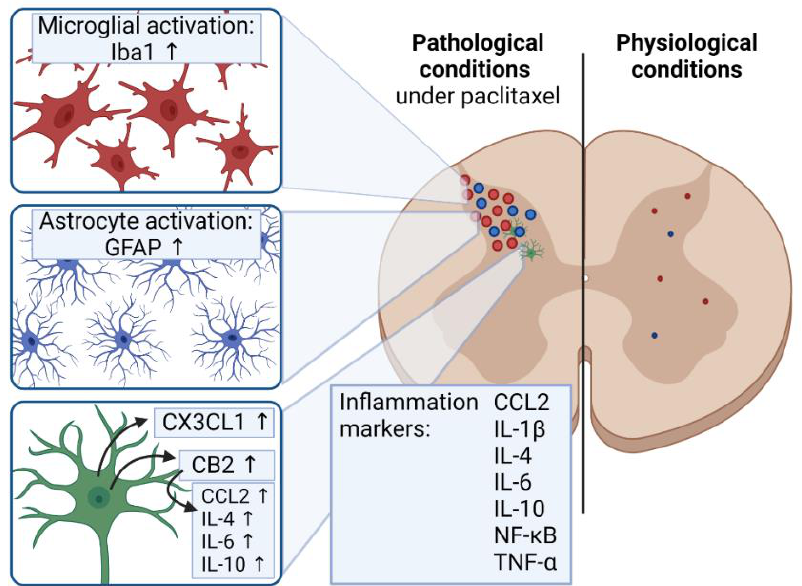
Figure 3. Pathomechanisms of paclitaxel-induced peripheral neuropathy in the spinal cord. CB2 —